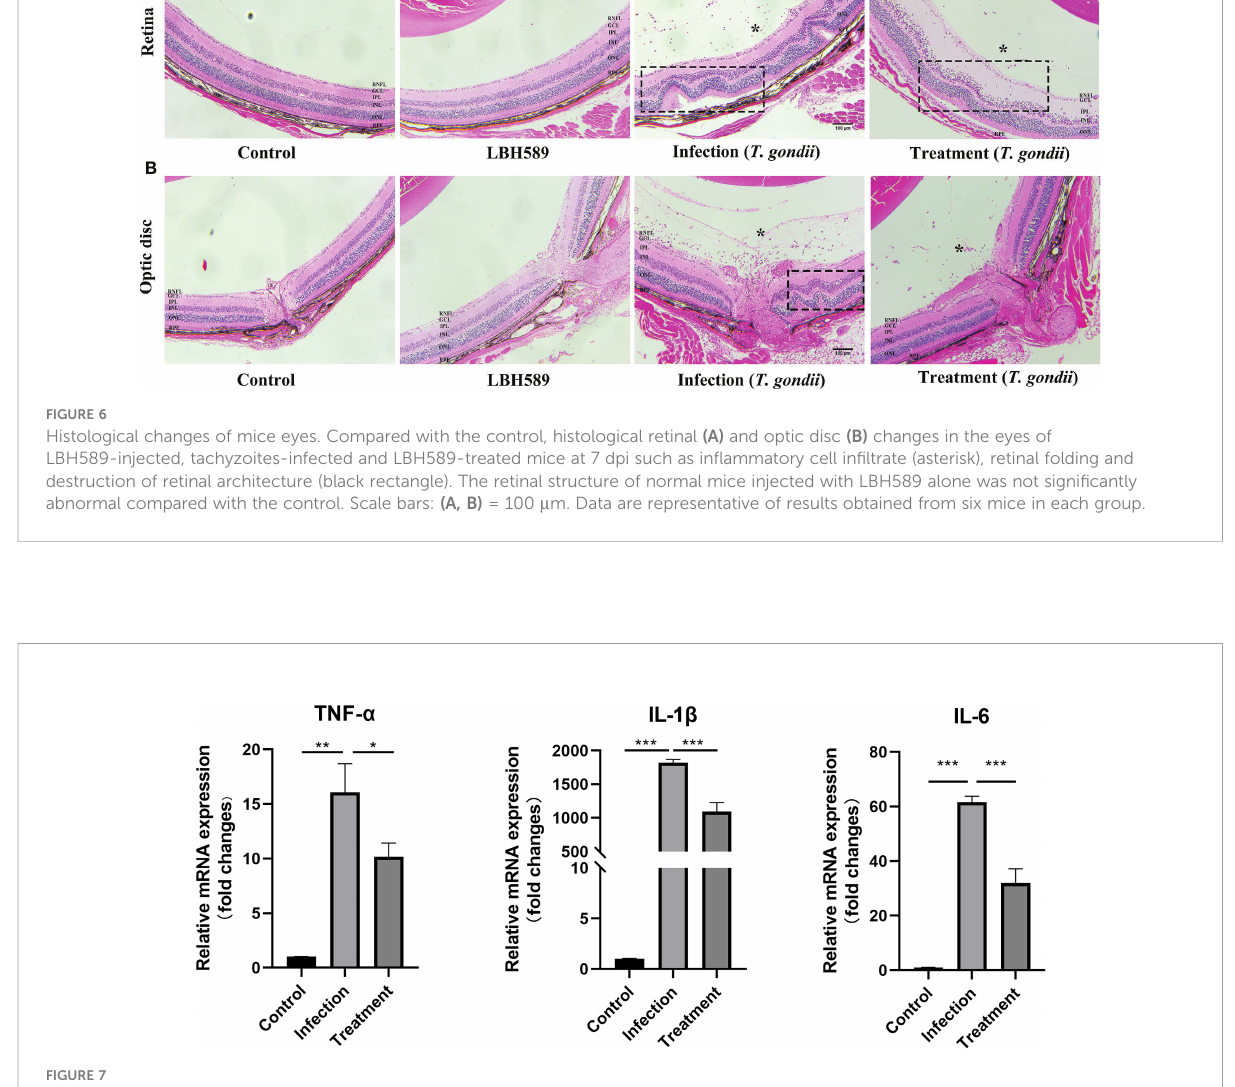
FIGURE 7 The differential mRNA expressions of TNF- a , IL-1 b and IL-6 in the eyes of the control, tachyzoites-infected and LBH589-treated mice were measured by qRT-PCR. * P < 0.05, ** P < 0.01, *** P < 0.001, the infection group versus the treatment group. The experiments were performed in triplicate, in three independent experiments.